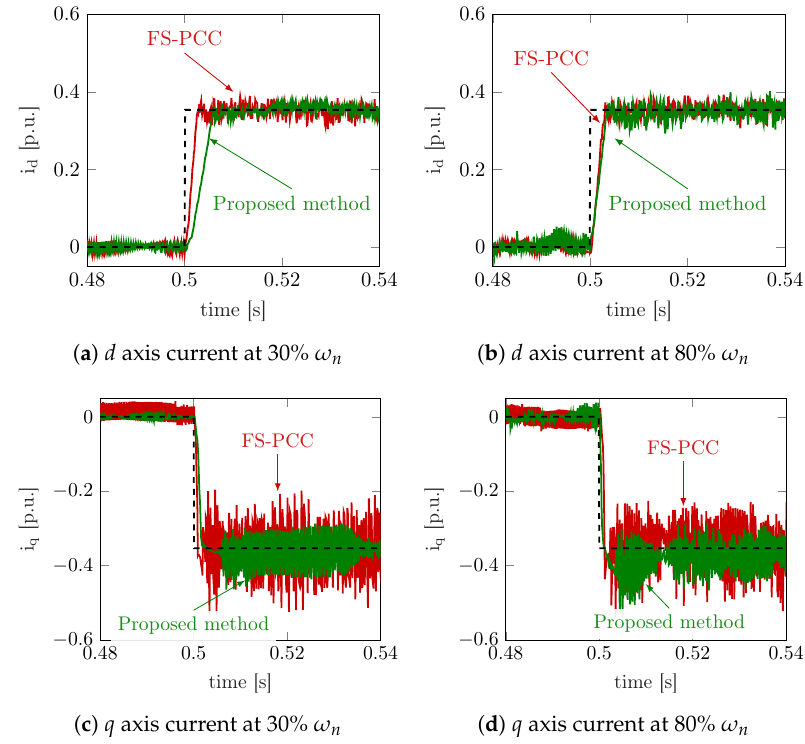
Figure 8. Current controllers performances to half-rated current step reference variations, SynRM 2